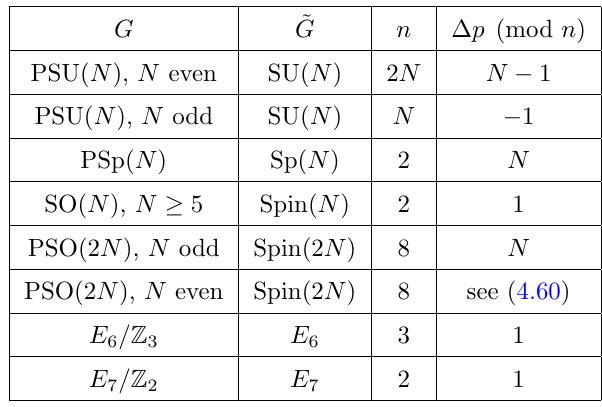
Figure 3. Table of gauge groups, (cid:18) periodicities and T